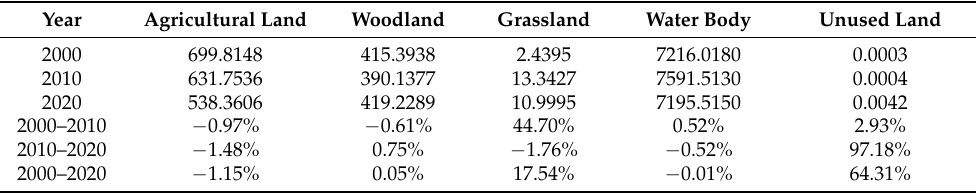
Table 4. Total ESV in southern Jiangsu [unit: CNY 100 million] and the changes [unit: